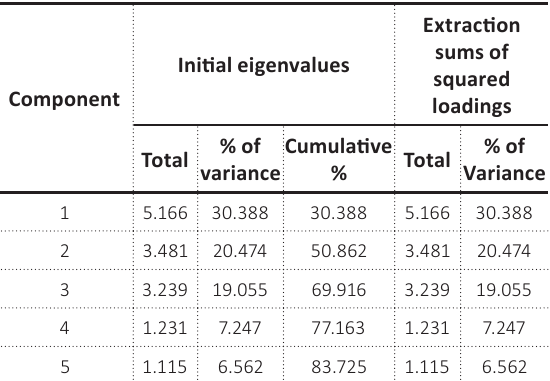
Table 5. Total variance explained